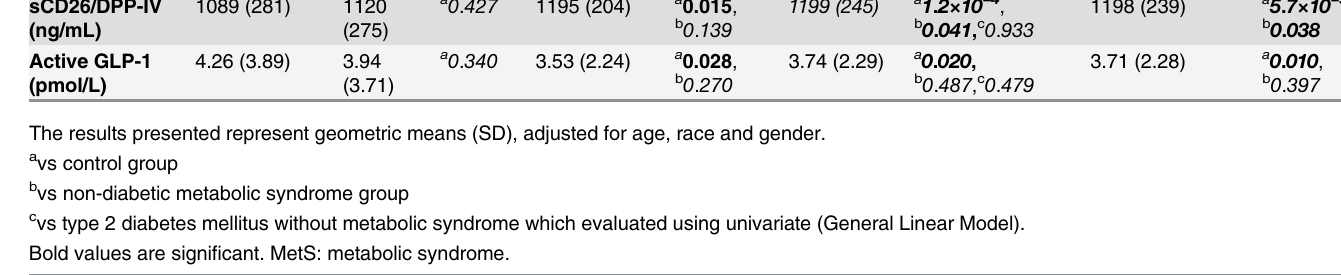
among T2DM patients The multiple linear regression analysis (adjusted for age, gender, race, and duration of diabetes) showed that serum levels of sCD26/DPP-IV in diabetic patients were associated with increased